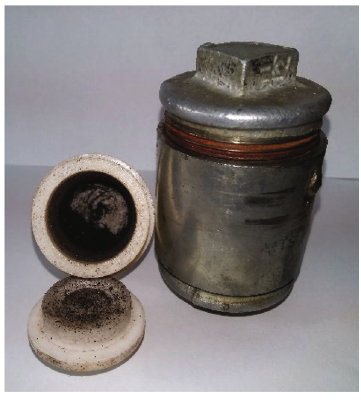
Figure 1: N-doped graphene quantum